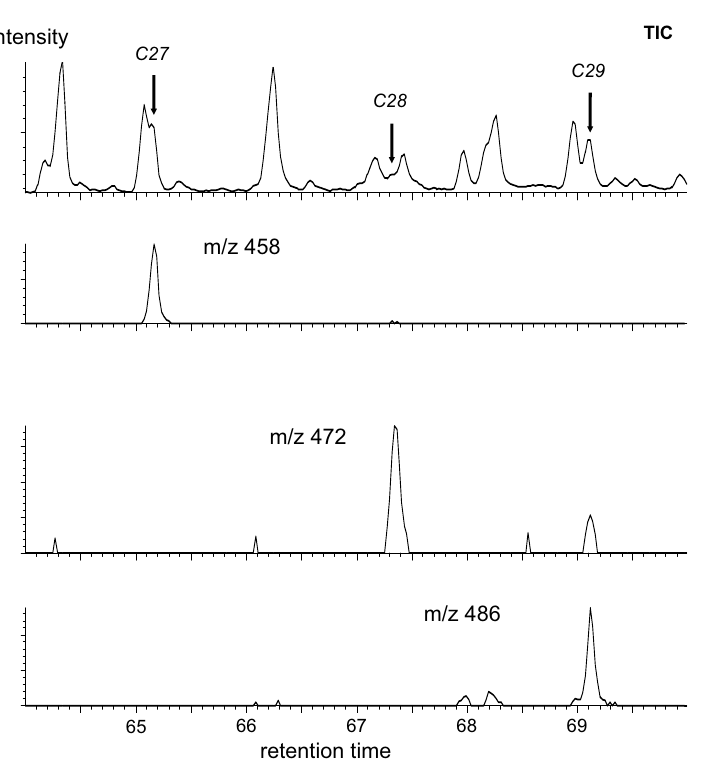
Fig. 6 – Total reconstructed ion current and selected mass fragmentograms indicating steroid